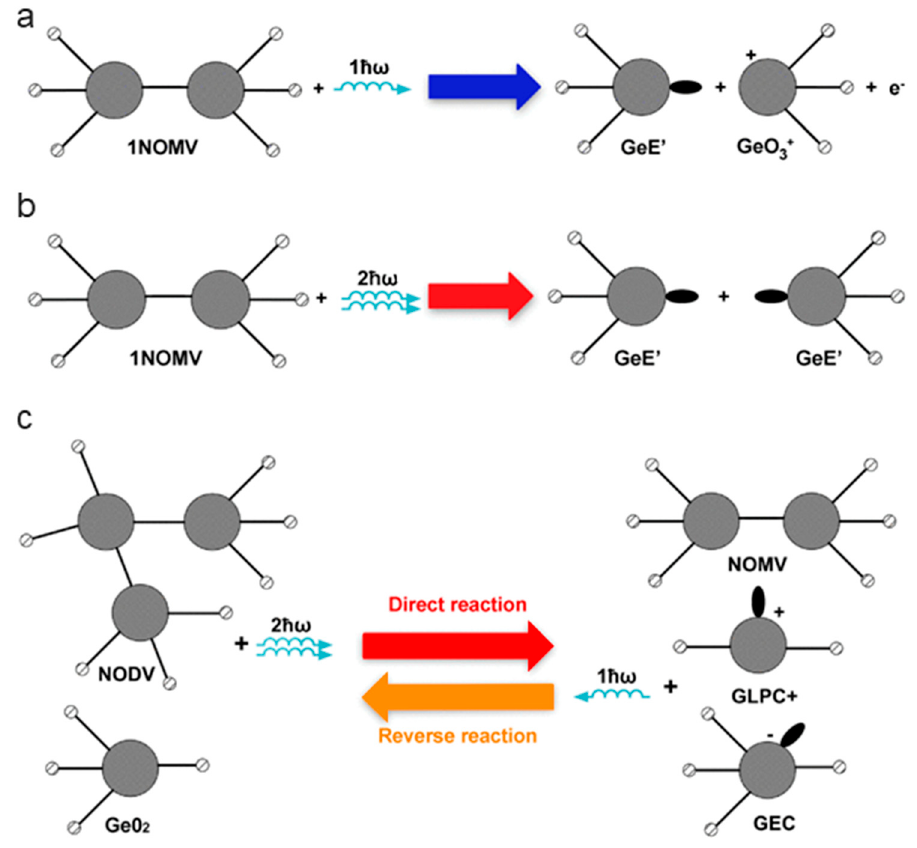
Figure 7. Proposed formation mechanisms of germanate defects. One-photon process ( a ), two-photon process ( b ), and balance reaction of one- and two-photon processes ( c ). Modified from [69].